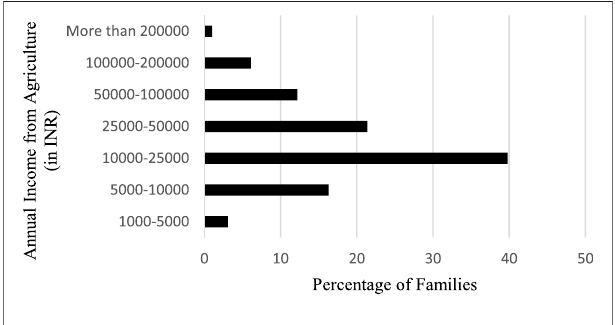
FIGURE 3 | Families ’ annual income from